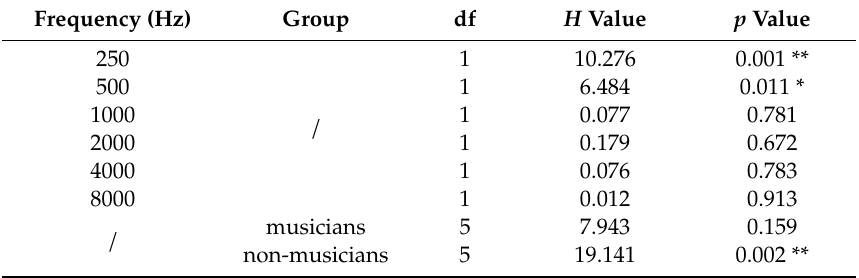
Figure 3. The mean values of pure tone audiometry (PTA) for musicians and non-musicians as a function of f p s. * p < 0.05, n.s ., not significant (two-factor Scheirer–Ray–Hare test). Vertical bars represent the standard errors of mean. Table 2. Simple effect results between the factors of group difference and frequency.